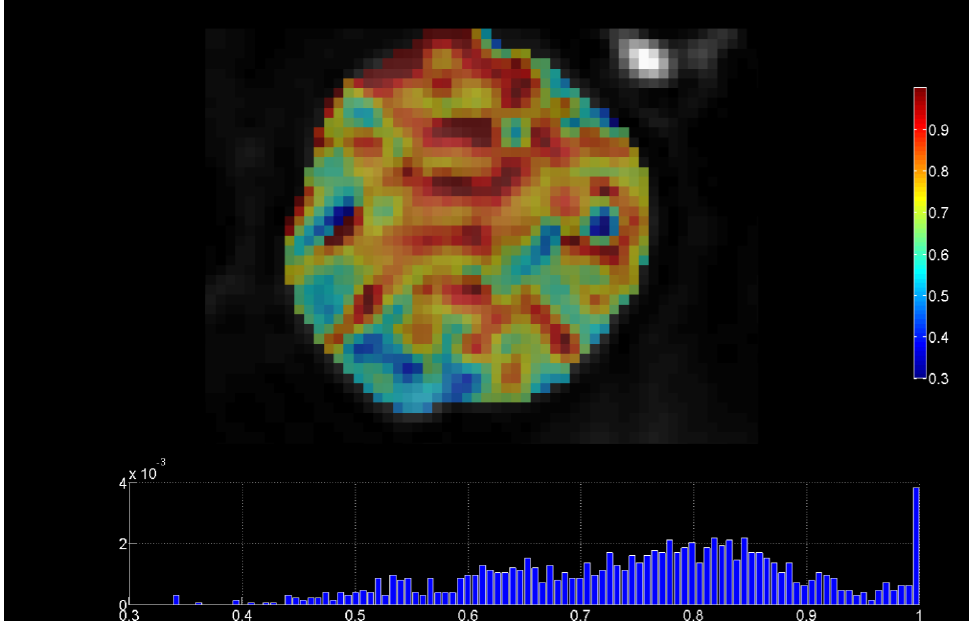
Figure 2. DWI-MRI stretched-exponential (SEM) DWI-MRI parametric map, revealing highly heterogeneous parts of a dedifferentiated liposarcoma (with permission from the department of Medical Imaging, Heraklion University Hospital). Heterogeneity index α ranges from 0 to 1, with lower values of α indicating microstructural heterogeneity.